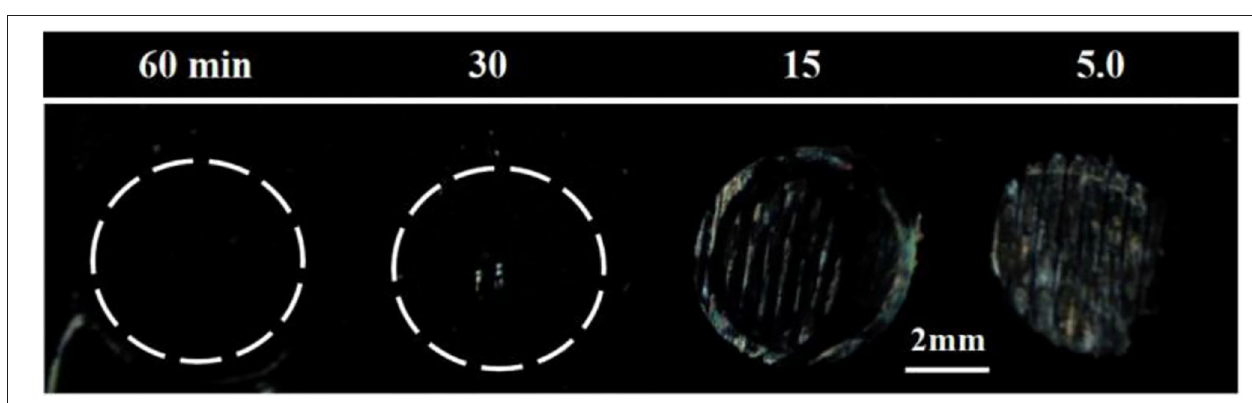
Frontiers in Chemistry |